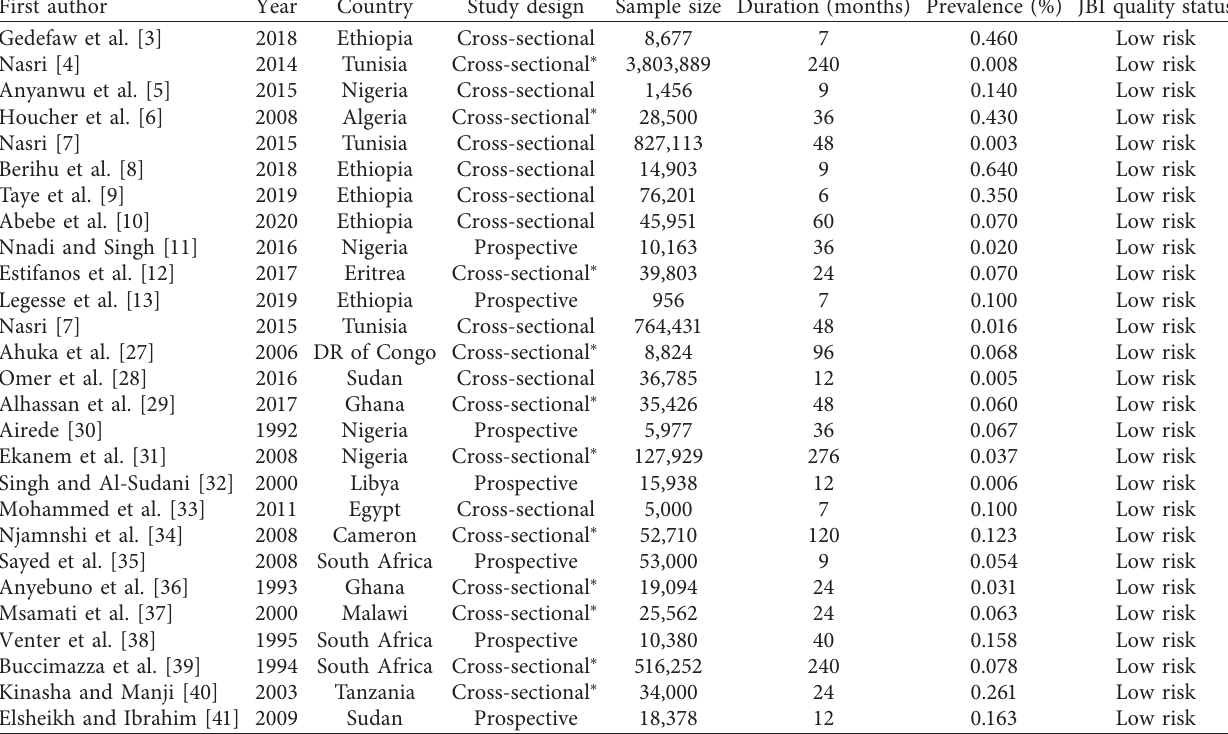
Table 1: The characteristics of original studies included in the systematic review and meta-analysis,